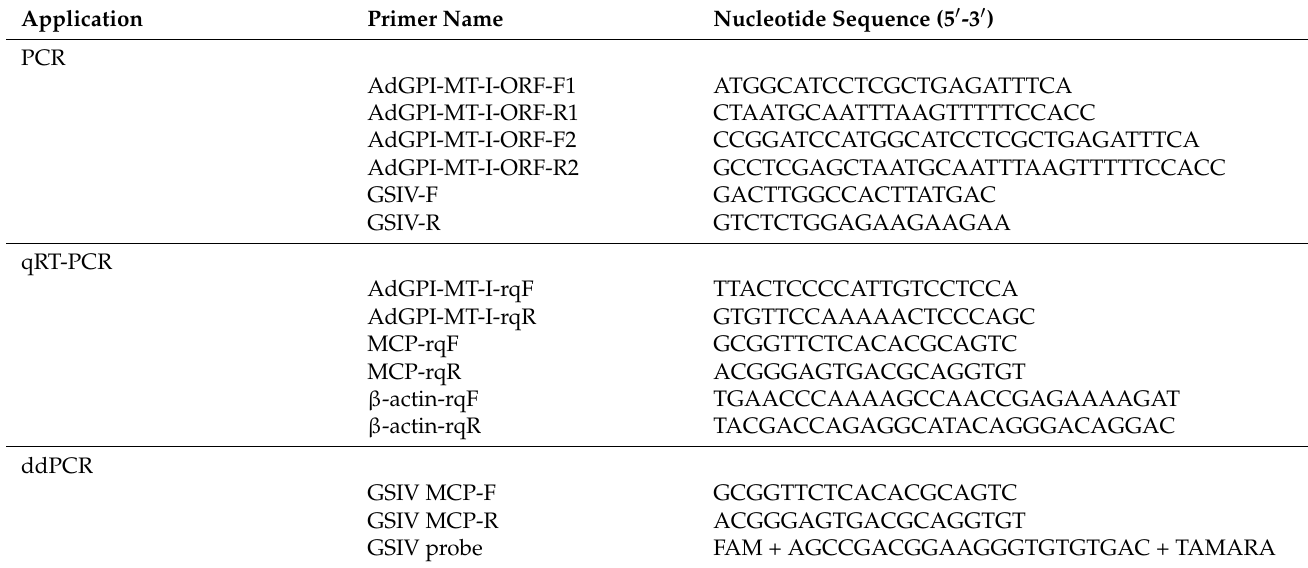
Table 2. The relevant primers used in this